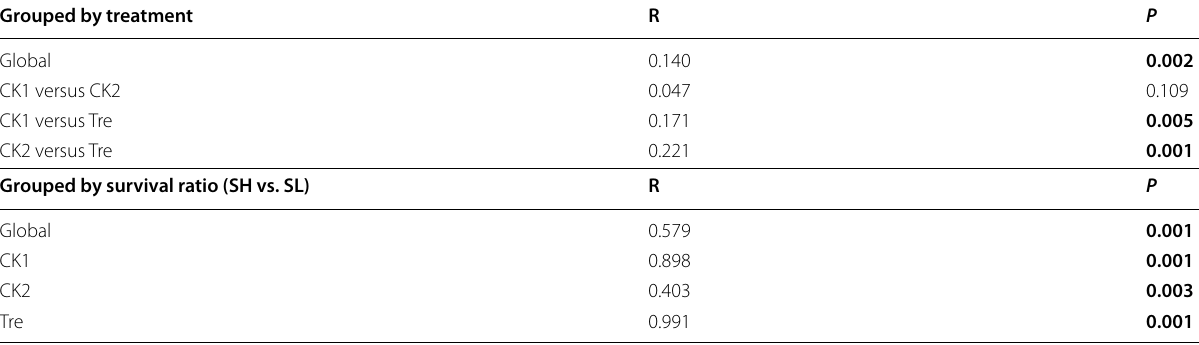
Table 2 Analysis of similarity (ANOSIM) of the difference in gut microbiota grouped by treatment and the survival ratio for each group, based on Bray–Curtis distance Grouped by treatment R Global 0.140